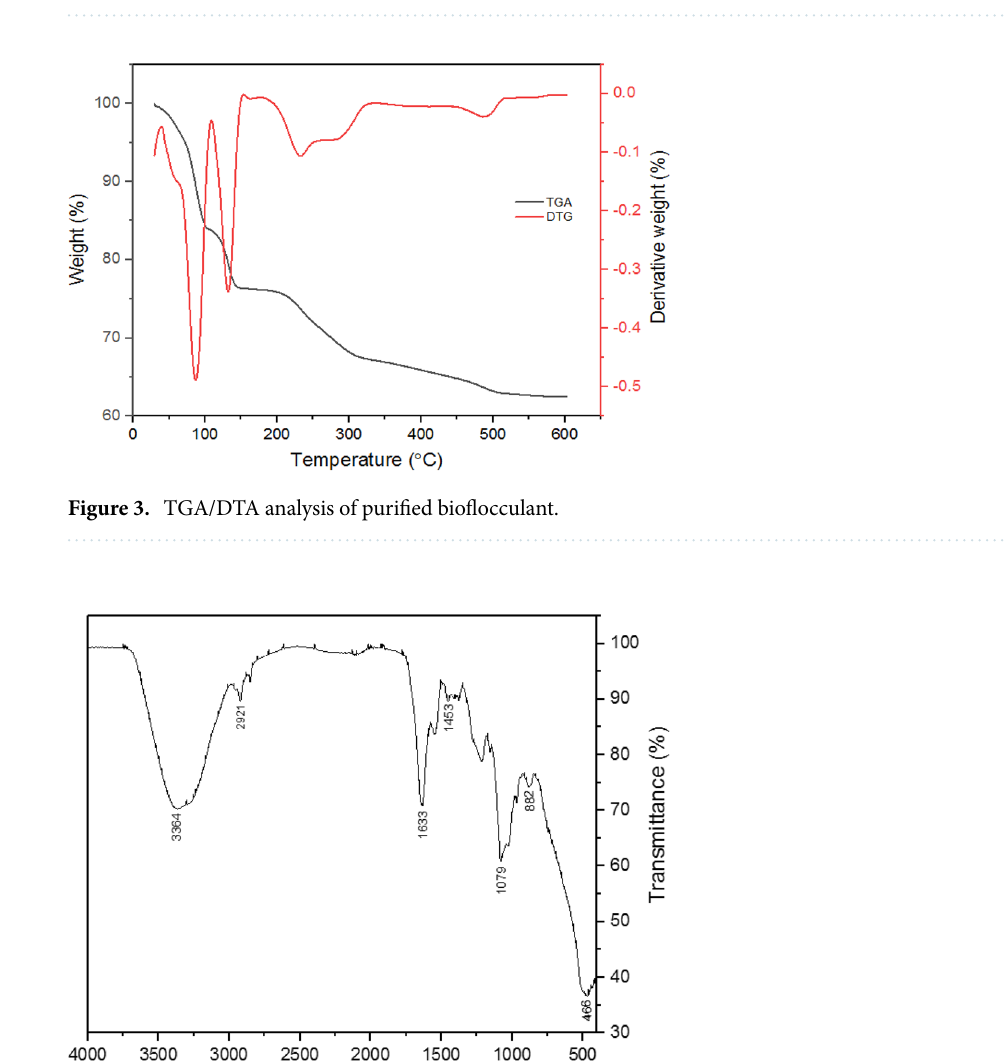
Figure 2. Surface plots of the influence of pertinent variables on the bioflocculation activity.